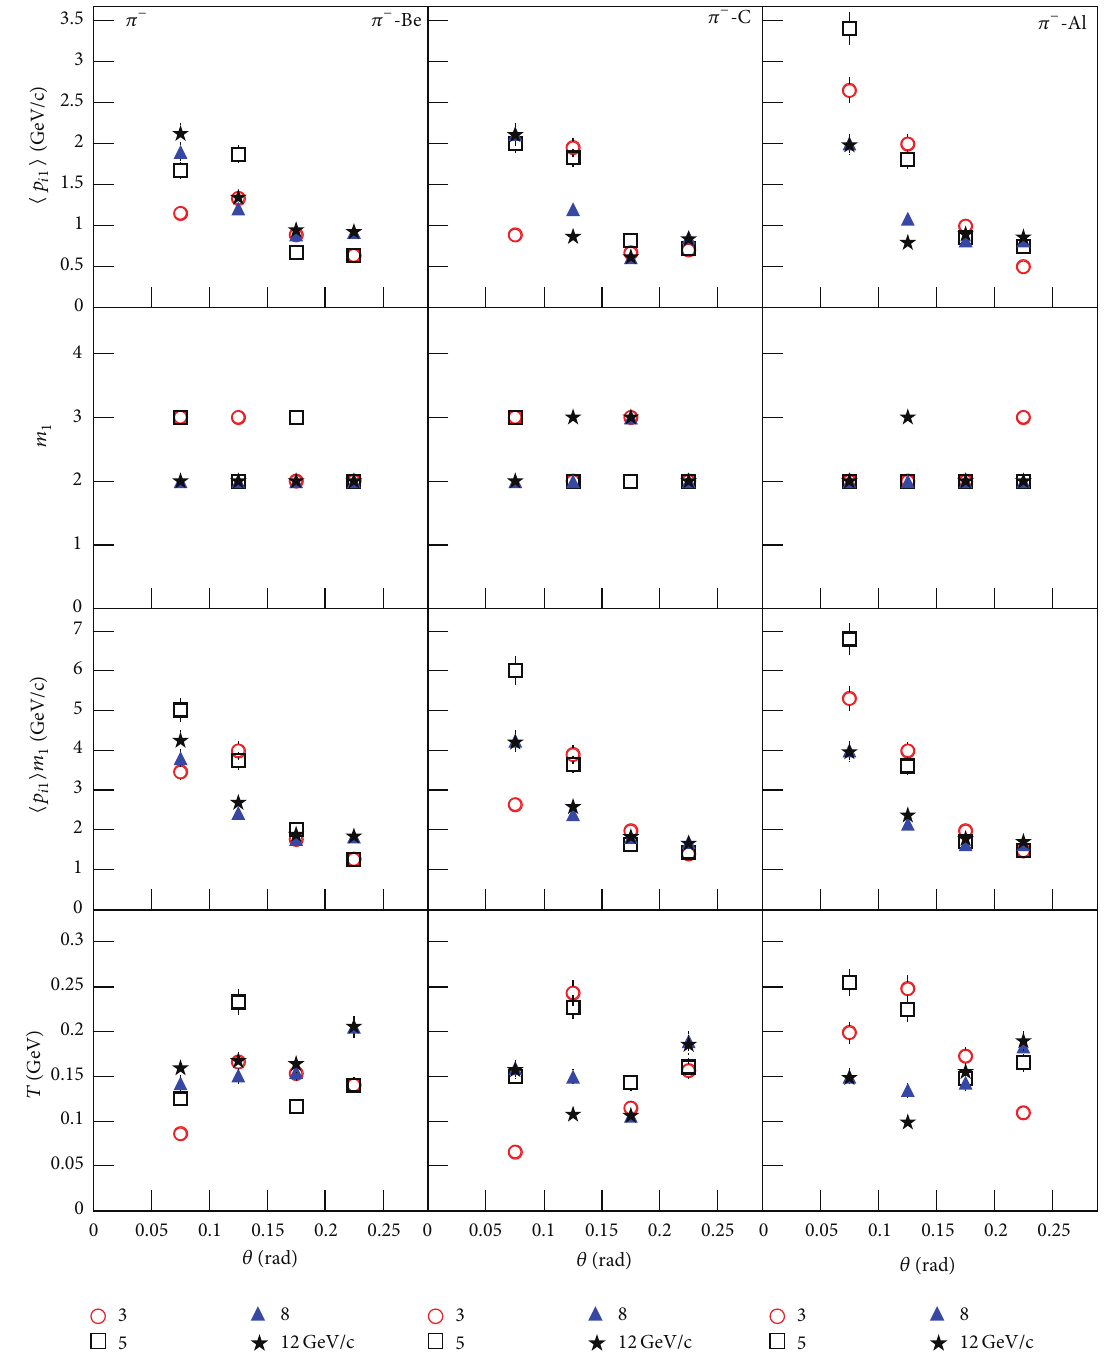
Figure 14: The same as Figure 13, but showing the results for 𝜋 − . The parameter values for targets Be, C, and Al are taken from Figures 2, 6, and 10,